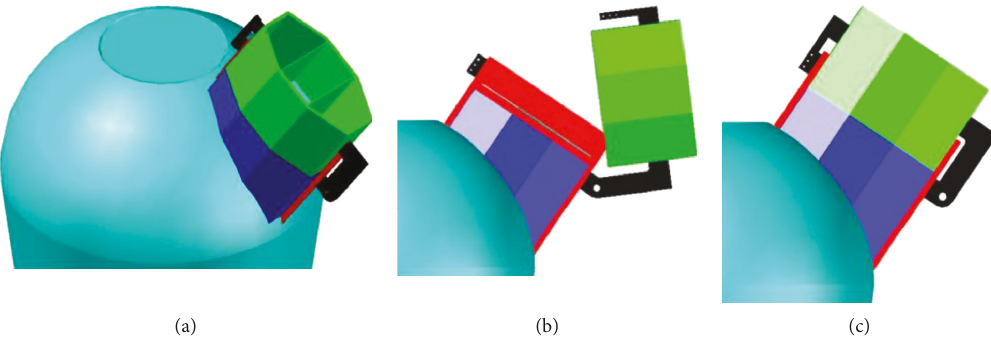
Figure 9: The original scheme of connection. (a) 3D schematic. (b) Initial state of the connection. (c) Completion status of the connection.